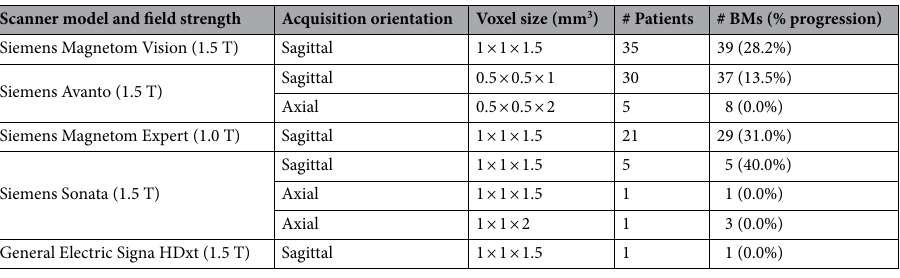
Table 2. Number of patients and BMs scanned by each of the MR scanner model and acquisition parameters configurations. Chi-squared test for progression yielded p = 0.226 across all scanner models and p = 0.069 across further investigated Vision, Avanto, and Expert